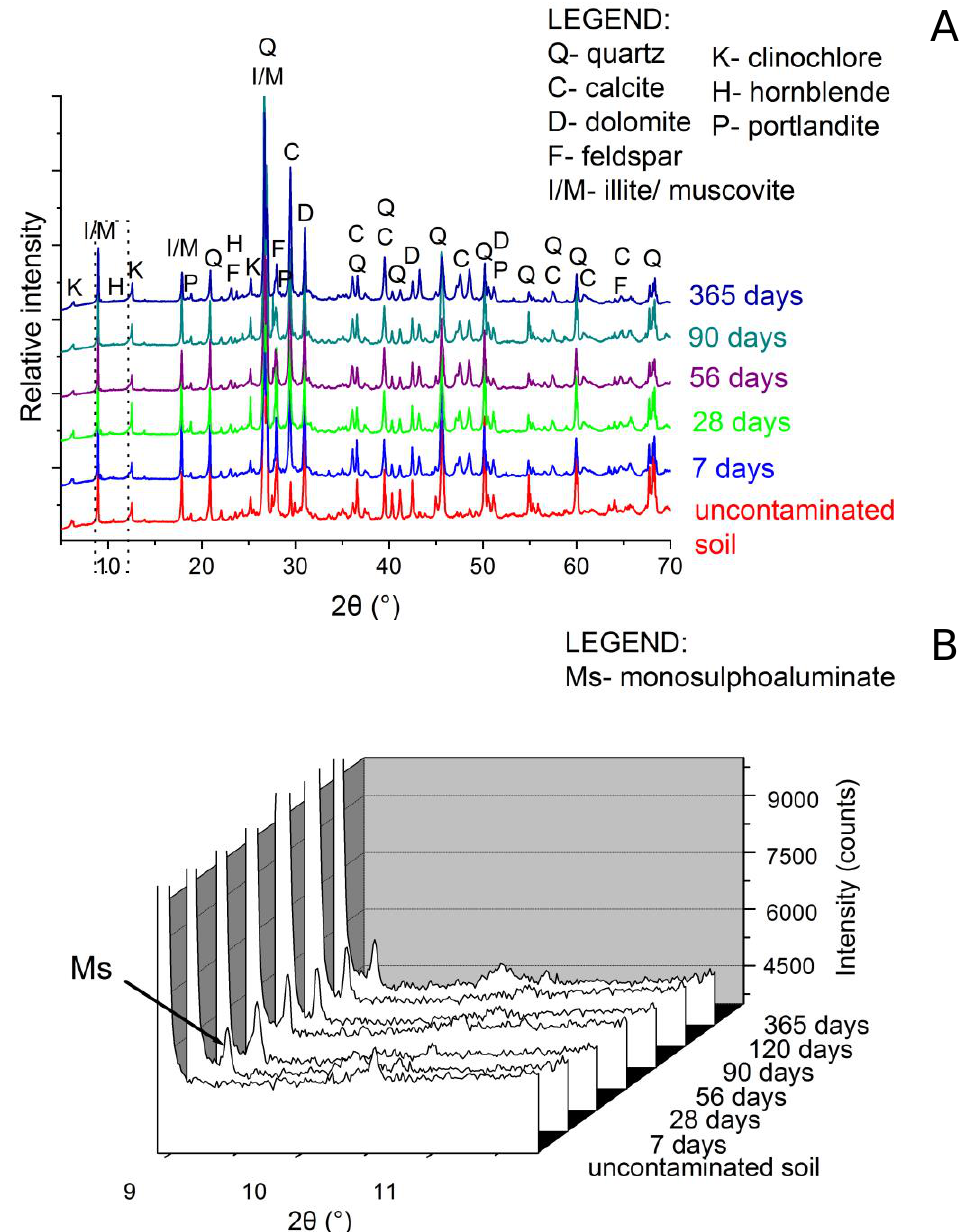
Figure 6. XRD patterns of ( A ) remediated soil and ( B ) corresponding section of the XRD patterns from 8.9°–11.8° 2θ with time elapsed after the remediation.